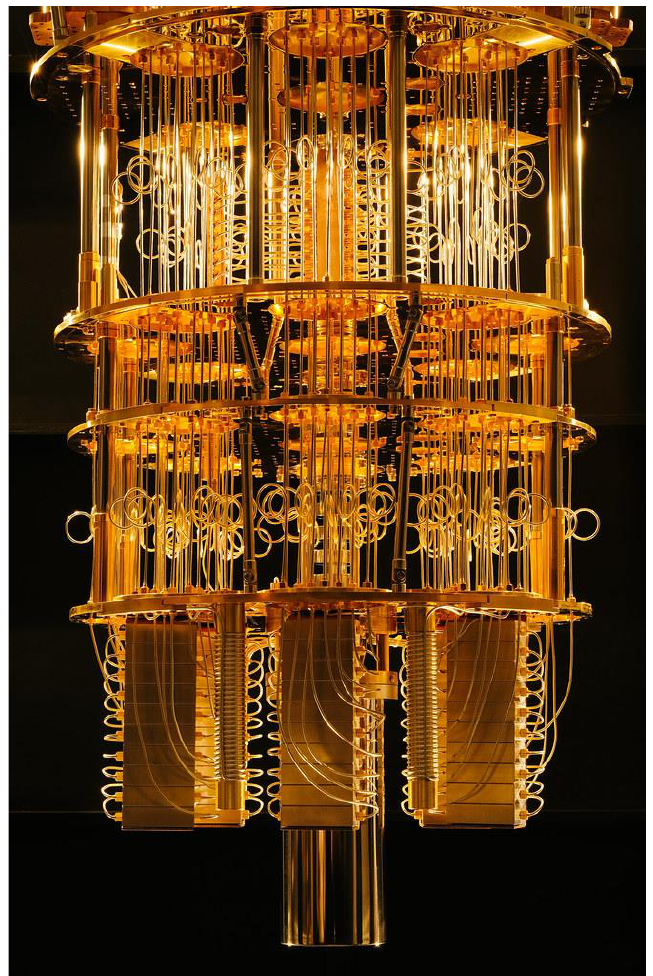
Figure 1. IBM quantum computer. Image Credit: Flickr.